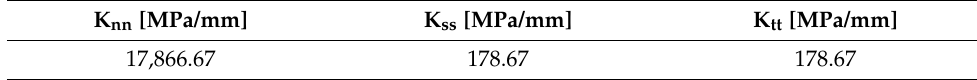
Table 14. Bond stiffnesses for FEM simulation of pull-out tests. K [MPa/mm]. nn